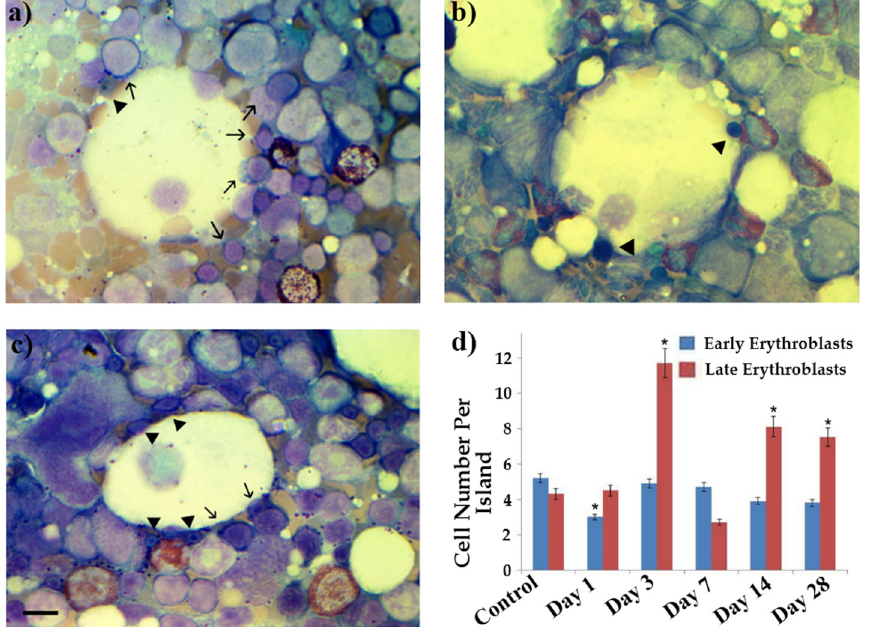
Figure 8. Erythroblastic islets and related erythroid cells. ( a ) Erythroblastic islets in healthy (anesthesia) rats’ bone marrow (early erythroblasts shown by arrows, late erythroblasts shown by triangles). ( b ) Erythroblastic islets in irradiated rats’ bone marrow on 1st day after irradiation. ( c ) Erythroblastic islets in irradiated rats’ bone marrow on 28th day after irradiation. ( d ) Changes in population of erythroid cells in erythroblastic islets in control and irradiated rats. * p < 0.05– p < 0.001 (compared to control). Scale bar is 10 μ m.